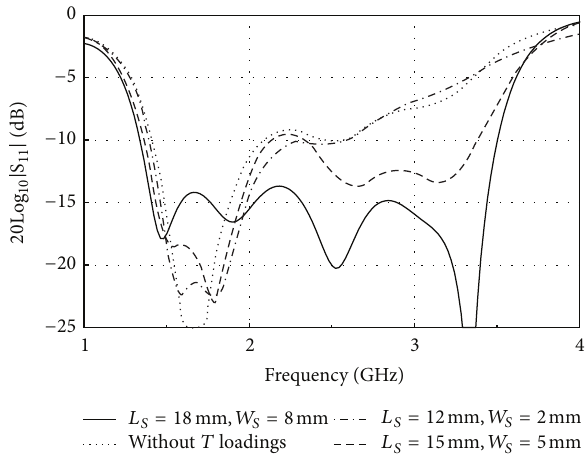
Figure 3: Effect of the T-shape loadings.